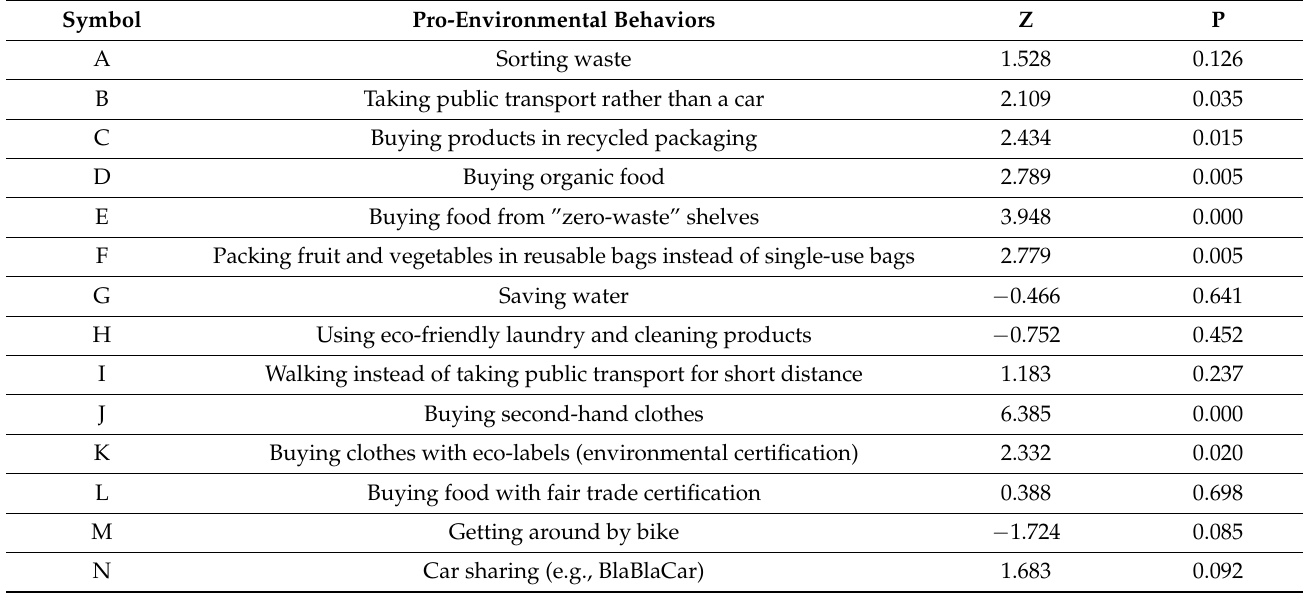
Table 3. Differences in the respondents’ evaluation of own pro-environmental behaviors by gender (Mann-Whitney test).